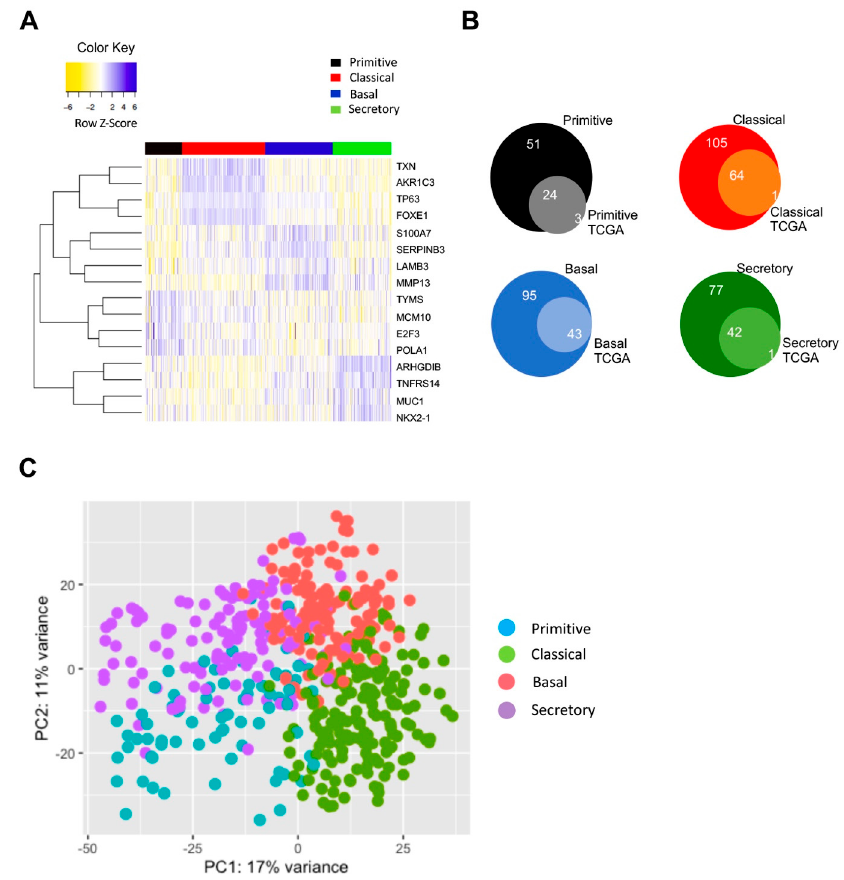
Figure 5. Partitioning of all LUSC TCGA tumors in four molecular subtypes. ( A ) Heatmap of 16 signature genes for each of the four subtypes of LUSC. ( B ) Venn diagrams of the four LUSC subtypes: smaller circle, previous TCGA classification of 178 tumors. Larger circles, complete classification of all 501 LUSC tumors in TCGA. ( C ) PCA (principal component analysis) of the four LUSC subtypes according to new